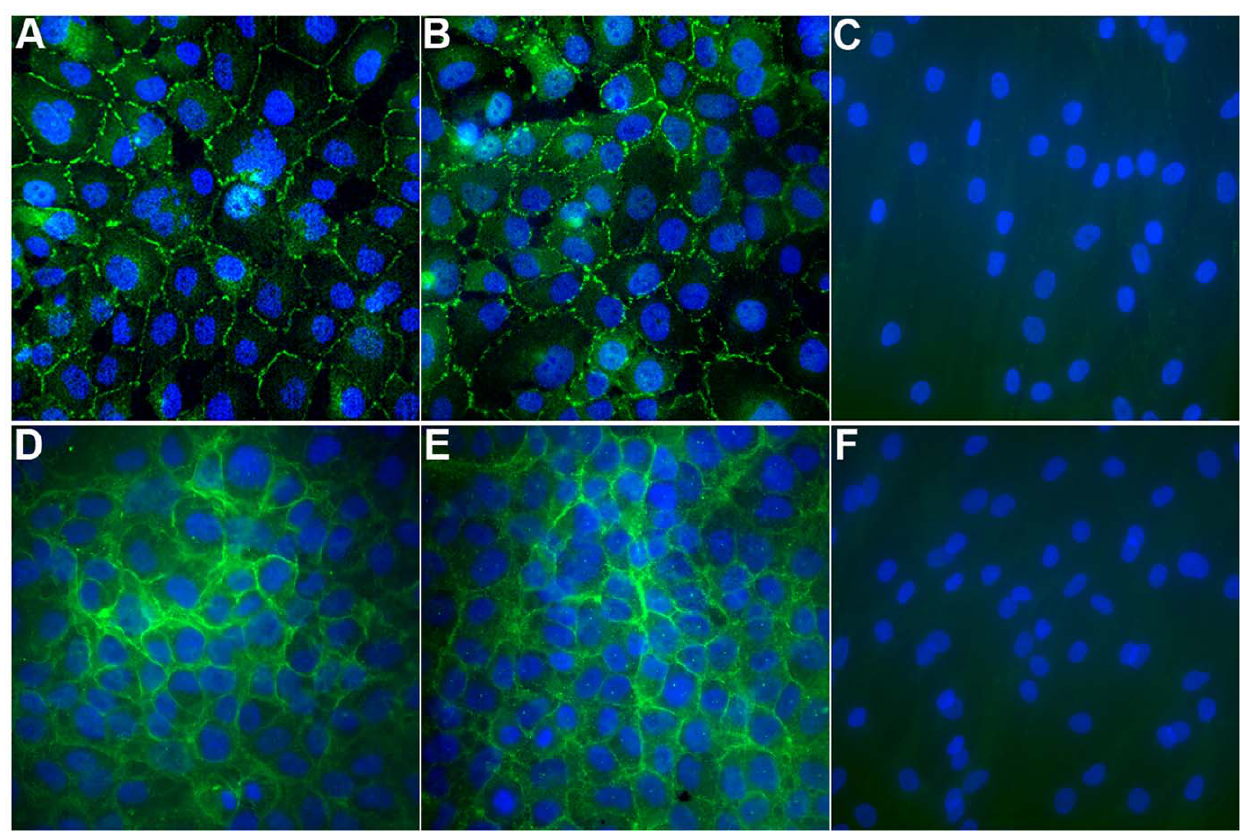
Figure 4. Immunofluorescence detection of ZO-1 and Na/K ATPase a 1 in HCEnC-21 and HCEnC-21T. (A–C) Confluent monolayers of passage-13 HCEnC-21 (A) passage-14 HCEnC-21T (B) and passage-3 primary stromal fibroblasts (C) were fixed and labeled for ZO-1 (green) and nuclei (blue). (D–F) Confluent monolayers of HCEnC-21 (D), HCEnC-21T (E), and primary stromal fibroblasts (F) were fixed and labeled for Na/K ATPase a 1 (green) and nuclei (blue). Note that ZO-1 and Na/K ATPase a 1 were detected in HCEnC-21 and HCEnC-21T but not in stromal fibroblasts, and localized to the cell-cell contacts and plasma membrane, respectively. 400x.